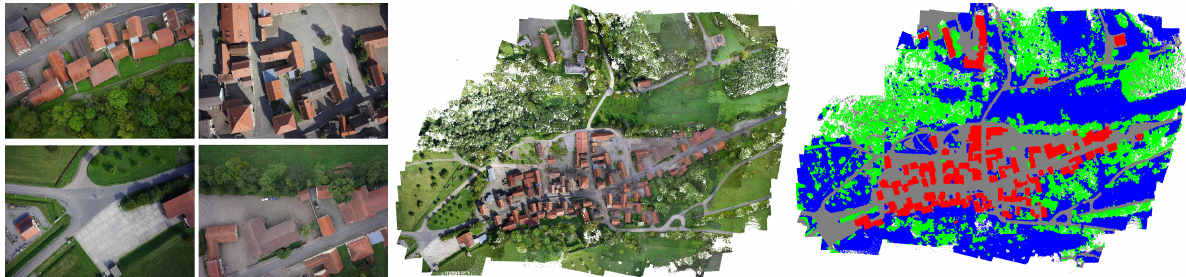
Figure 1. Village dataset: The four images on the left each show one of 296 36-megapixel input images acquired from an Unmanned Aerial Vehicle (UAV). In the middle the noisy point cloud derived from disparity maps accumulating half a billion 3D points is given. On the right the classification results for buildings (red), ground (gray), grass (blue) and trees (green) are presented. In spite of the huge amount of input data, our method allows for the classification within a couple of hours on a single PC.